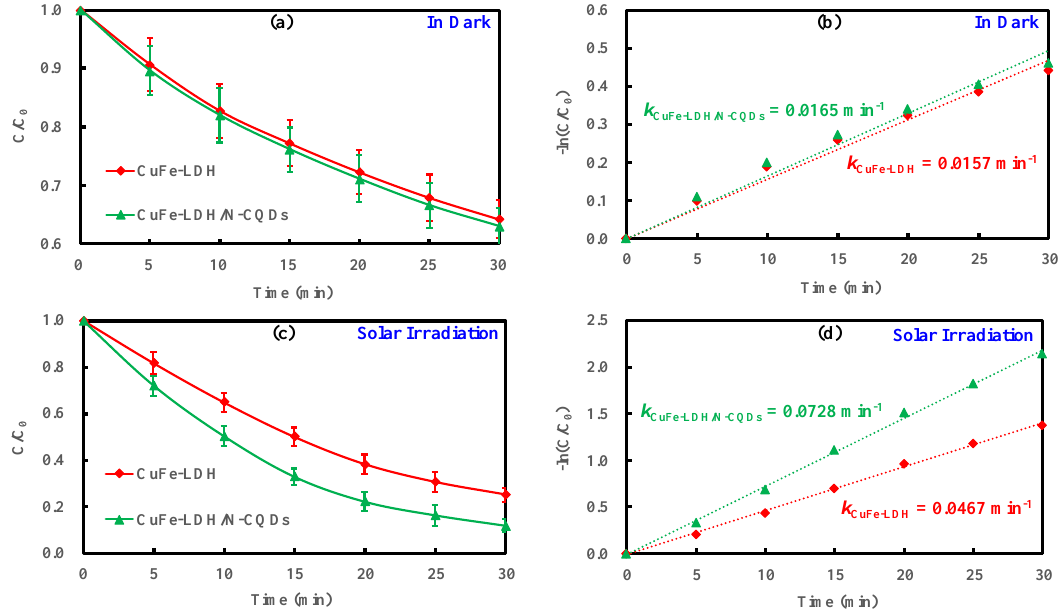
Figure 4. ( a ) Degradation of methylene blue (MB) in darkness. ( b ) Pseudo-first-order kinetic fit for MB degradation in darkness. ( c ) Photo-Fenton degradation of MB under simulated solar irradiation and ( d ) Pseudo-first-order kinetic fit for MB photodegradation under simulated solar irradiation. Error bars represent standard deviation of triplicate runs.